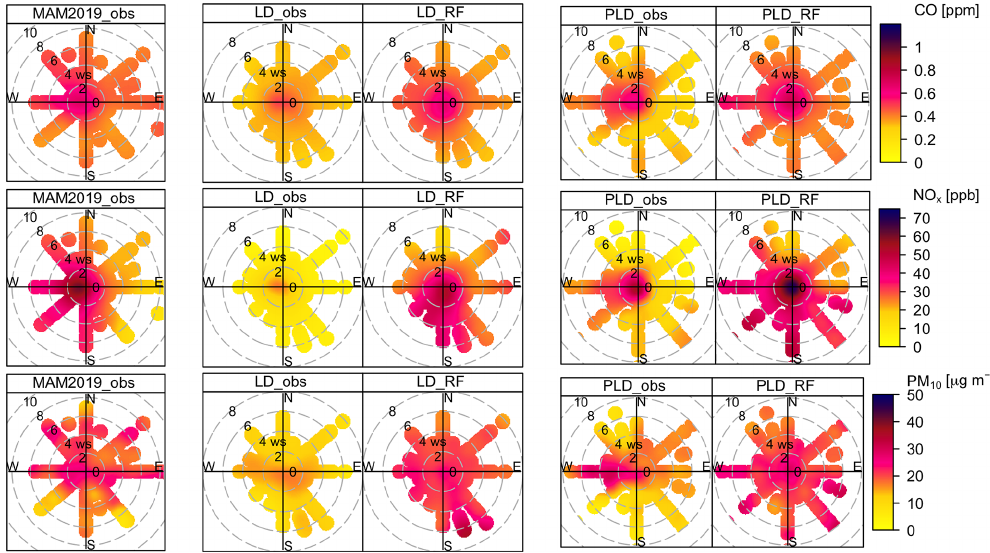
Figure 9. Bivariate polar plot for PC of hourly means for observations during MAM2019 and the lockdown periods versus the BAU scenario estimated with the RF model. The radial axis represents wind speed, the angular axis represents wind direction, and the color scale represents pollutant